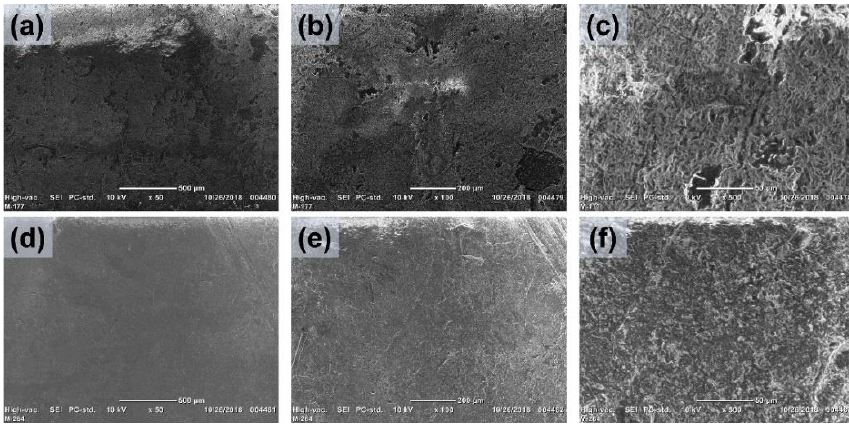
Figure 3. SEM images of ( a – c ) PP- g -MMA (17%) and ( d – f ) (PP- g -MMA)- g -NVI (19.5/6%), aug- mented from left to right ×50, ×100, and ×500. from left to right × 50, × 100, and × 500.